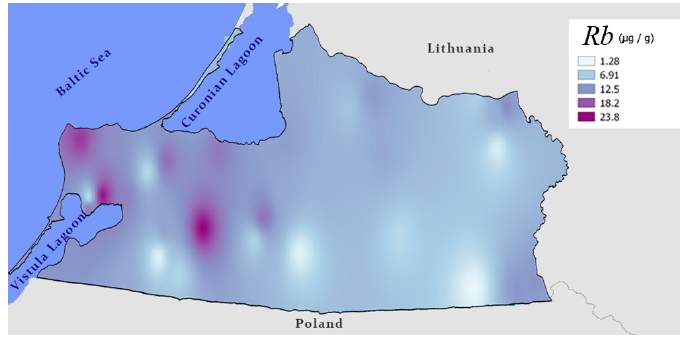
Figure 8. Distribution of rubidium in the thalli of H. physodes in the Kaliningrad region, 2010. The average copper concentration in the lichen H. physodes was 7.91 μ g/g, with the lowest coefficient of variation. Sampling homogeneity was confirmed. The maximum copper concentration was 9.94 μ g/g.